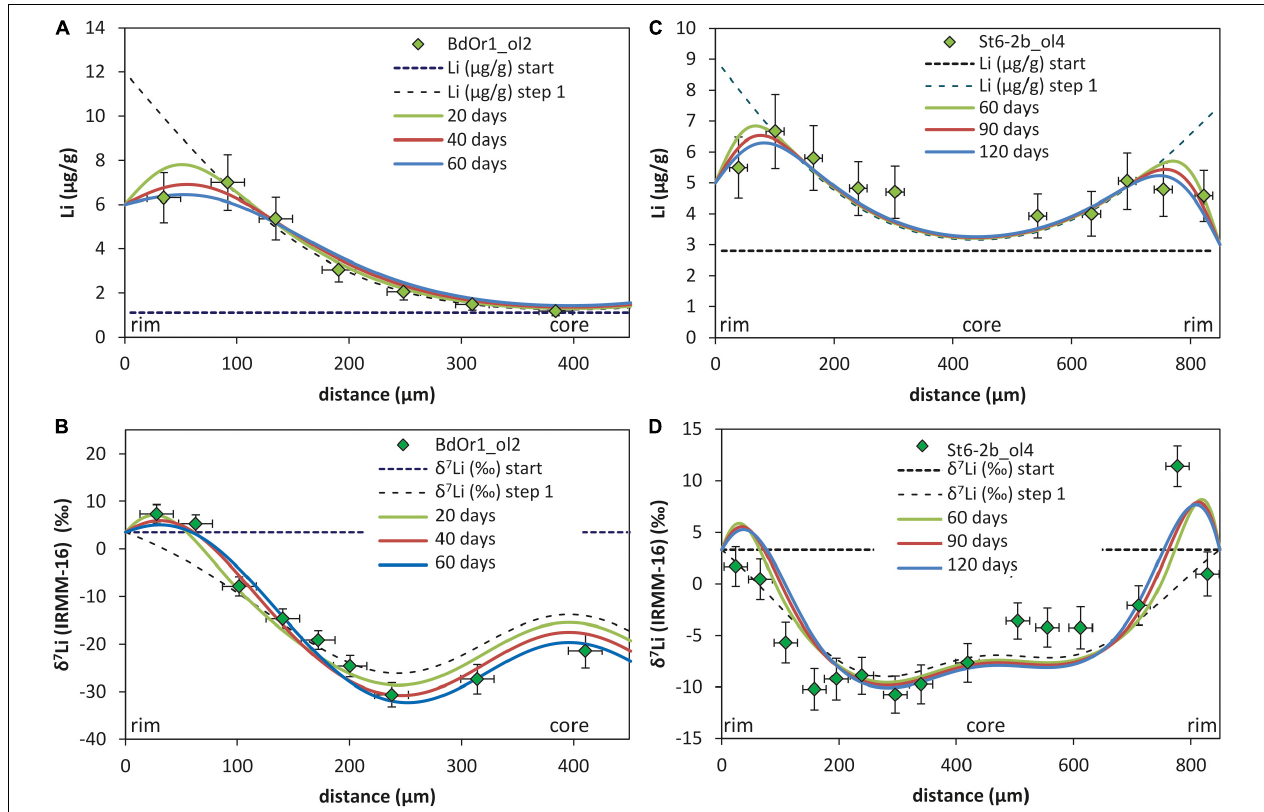
FIGURE 6 | Two step model of Li concentration (A,C) and Li isotope profiles (B,D) fitted with t = 239–252 days for Banne D’Ordanche (BdOr1_ol2) and t = 3.26 years for Roche Sauterre (St6-2b_ol4b) for the first diffusion event (dashed lines, time scales are taken from Oeser et al., 2015). The time scales for the second diffusion event are modeled be fitting the observed Li concentrations and isotope compositions at the rims of the olivines are indicated by the solid lines. The models of all other investigated samples can be found in Supplementary Figure S.3 .